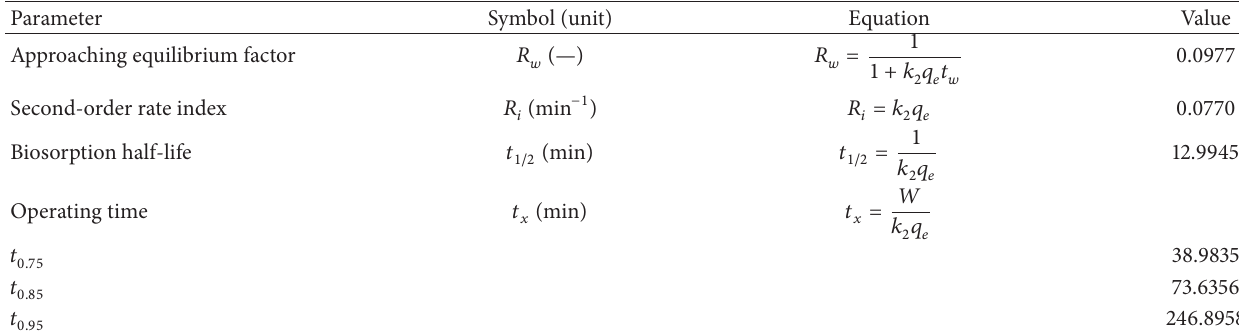
Table 7: Dye biosorption performance data based on pseudo-second-order